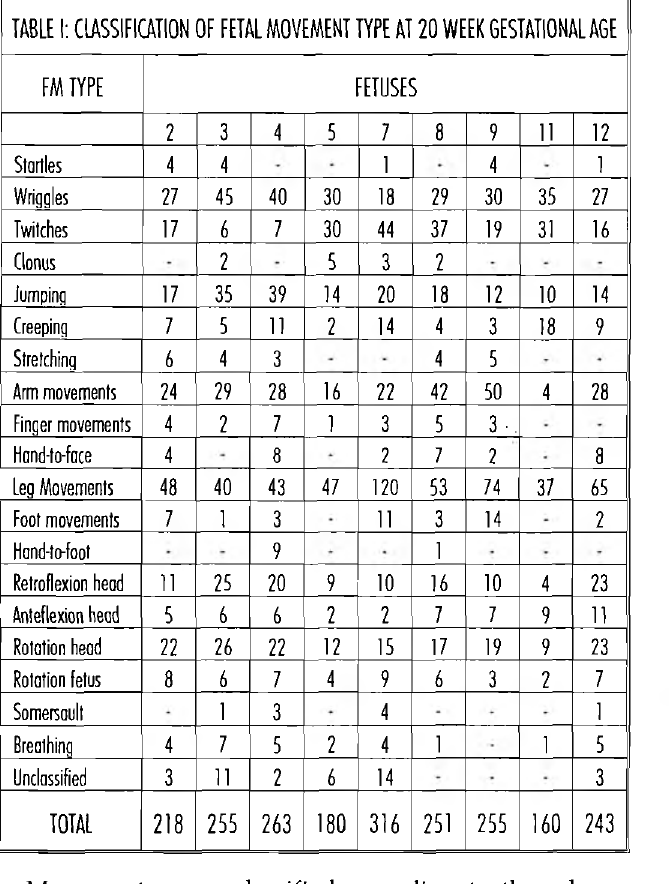
TABLE I: CLASSIFICATION OF FETAL MOVEMENT TYPE AT 20 WEEK GESTATIONAL AGE FM TYPE